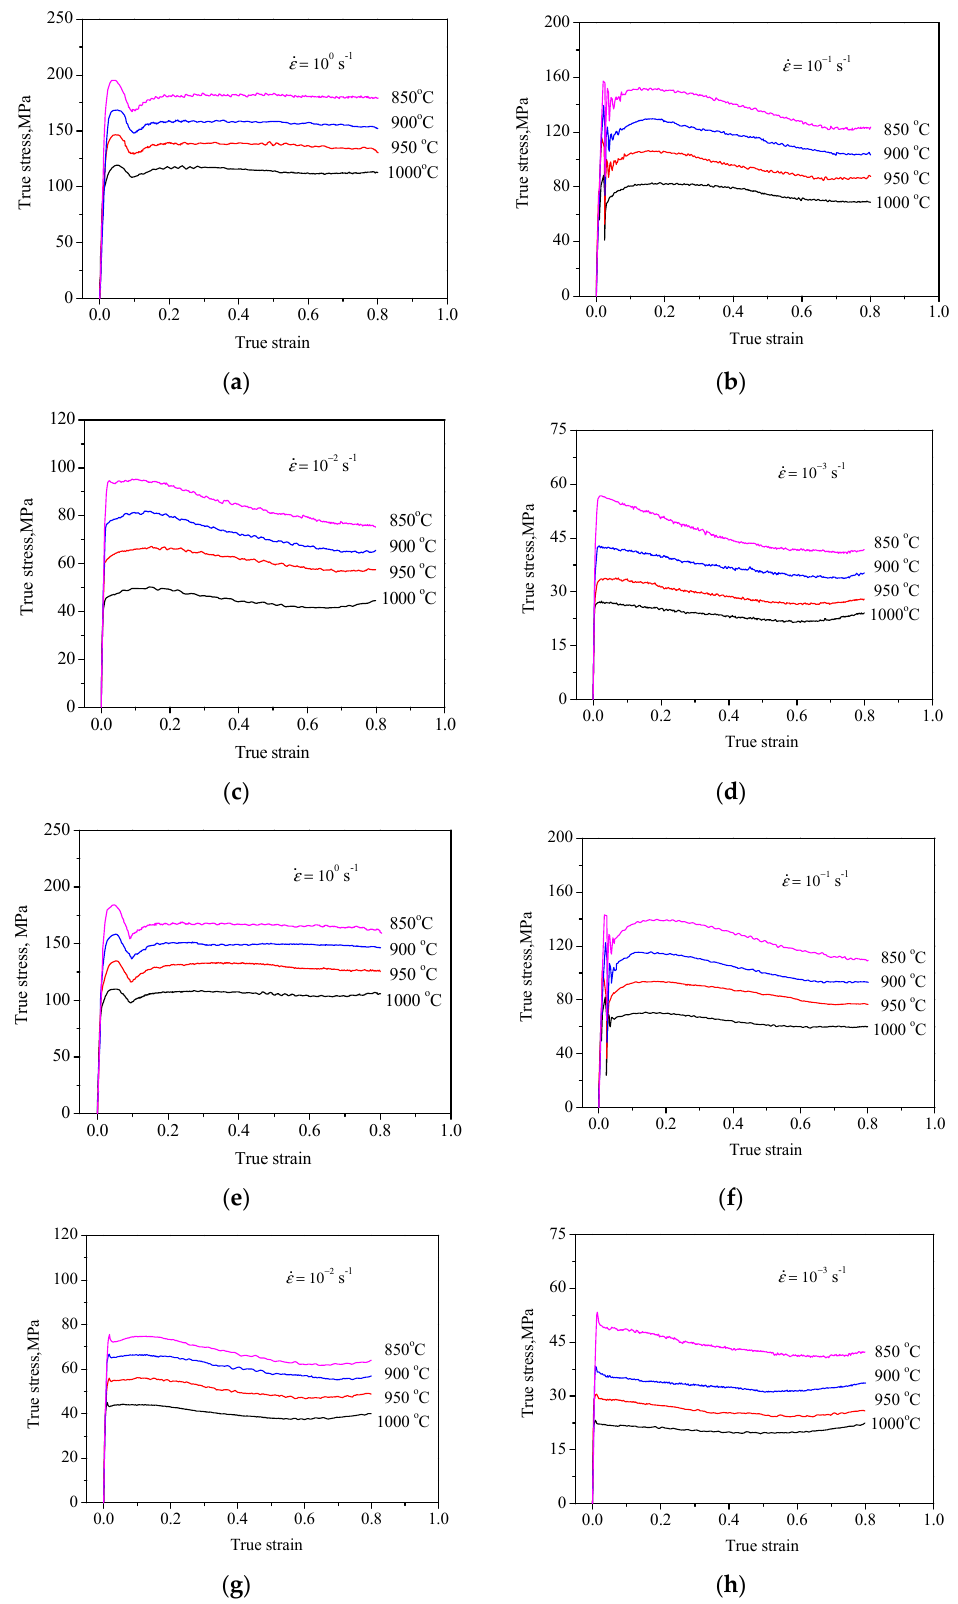
Figure 2. Stress-strain curves for the coarse-grained ( a – d ) and fine-grained ( e – h ) TB8 titanium alloys deformed at different strain rates.